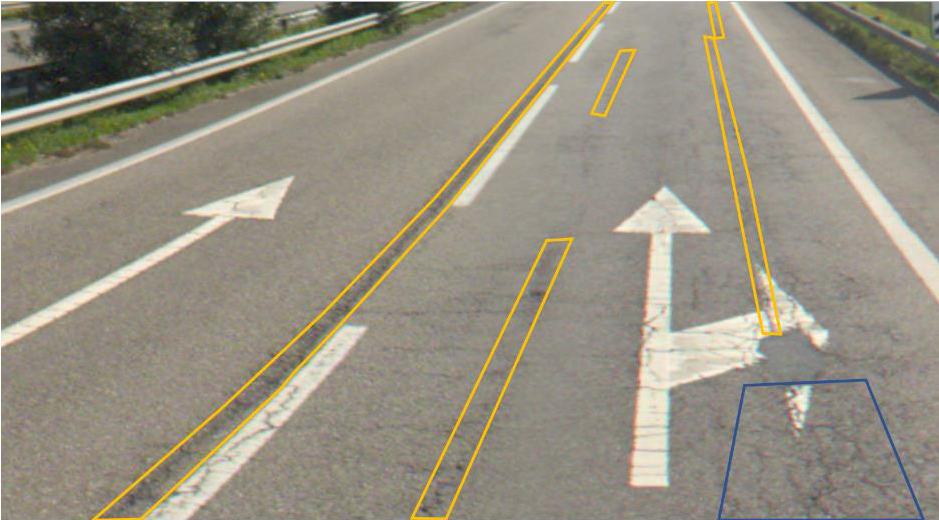
Figure 15. Road spot 3. Ladybug camera image with delimited cracked areas.